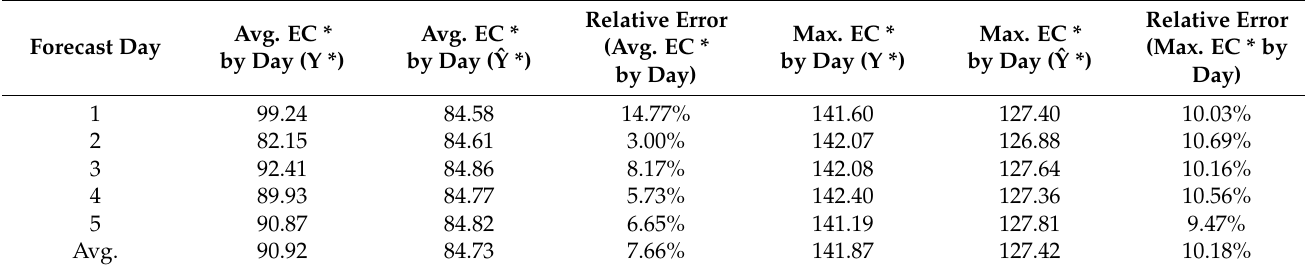
Table 11. Calculation of the relative error of the daily energy consumption (average and maximum) with respect to the testing-set (model: